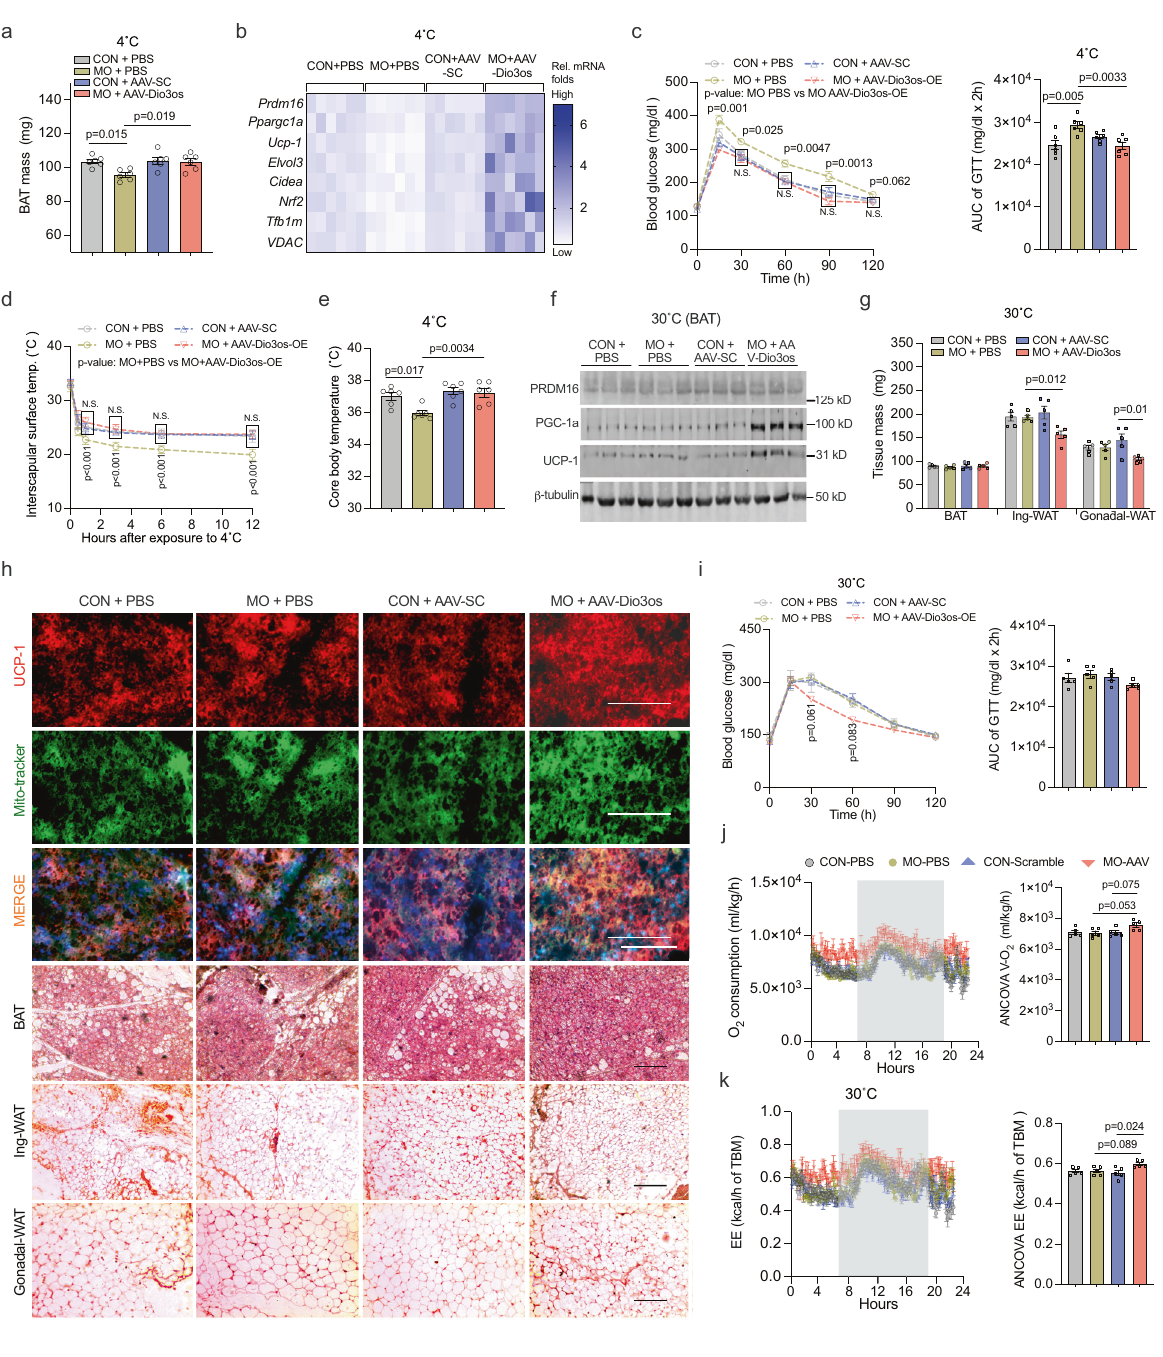
Fig. 7 Dio3os activation in BAT improves MO female offspring 4 °C-cold resistance, and energy expenditure and glucose tolerance at 30 °C. a After 4 °C exposure for 4 days, BAT mass in 8-week-old normal and MO female offspring administrated with PBS, AAV8-scramble-CMV or AAV8-Dio3os-CMV viral particle in BAT (1.5 × 10 11 vg per mouse, n = 6). b Heatmap displaying mRNA expression of brown thermogenic and mitochondrial biogenic genes in BAT after 4 °C exposure ( n = 6). mRNA expression was normalized to 18 S rRNA. c Glucose tolerance of offspring at 4 °C ( n = 6). d , e Interscapular surface ( d ) and rectal body temperature ( e ) in offspring at 4 °C ( n = 6). f – j Normal and MO female neonates were administrated with PBS, AAV-scramble, or AAV-Dio3os in BAT (1.5 × 10 11 vg per mouse) and further acclimated to 30 °C for 5-wk ( n = 5). f Immunoblotting measuring PRDM16, UCP-1, and PGC- 1a proteins in offspring BAT at 30 °C ( n = 5). β -tubulin was used as a loading control. g BAT, inguinal- and gonadal-WAT mass in offspring at 30 °C ( n = 5). h Immunostaining of UCP-1 and mito-tracker in BAT, and H&E staining of BAT, inguinal- and gonadal-WAT ( n = 5). Scale bar 250 µ m in immunostaining and 200 µ m in H&E. i Blood glucose concentration after intraperitoneal glucose administration in offspring for glucose tolerance test at 30 °C ( n = 5). j , k O 2 consumption ( j ) and energy expenditure ( k ) in offspring at 30 ° C ( n = 5). Metabolic data were regressed to body mass according to guidelines of ANCOVA NIDDK MCCP tool. Data are presented as mean ± s.e.m. Two-way ANOVA with Bonferroni post hoc analysis was used in data